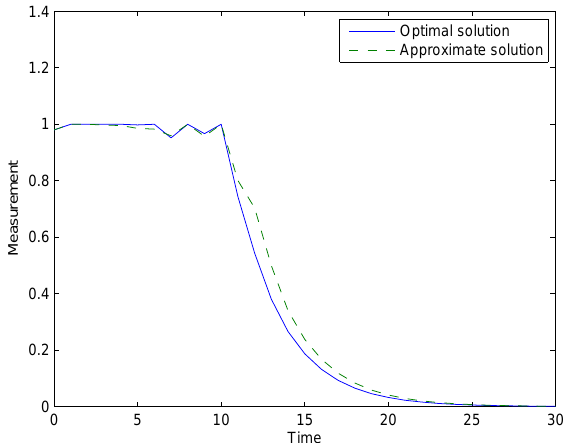
Figure 2: Comparison of the response with the optimal and approximate controller for Example